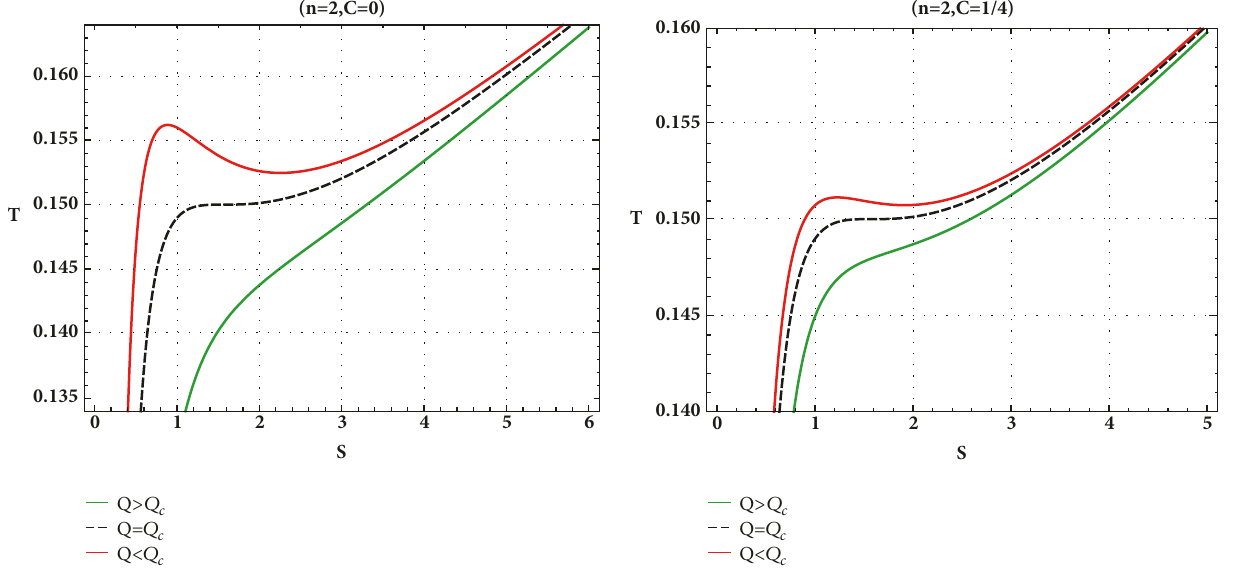
Figure 1: The temperature as a function of the entropy for different values of charge 𝐶 . (Left) 𝐶 = 0 . (Right) 𝐶 ̸= 0 .